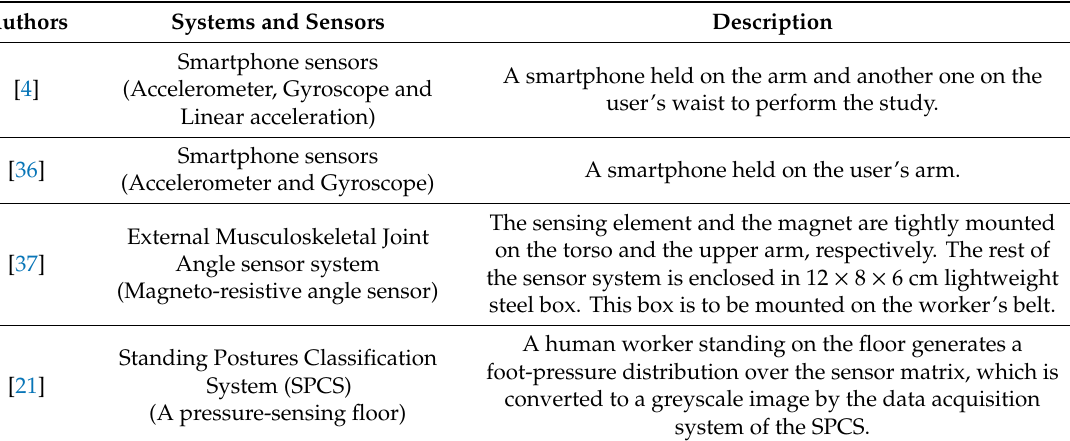
Table 2. Examples of MSD measurement technologies.